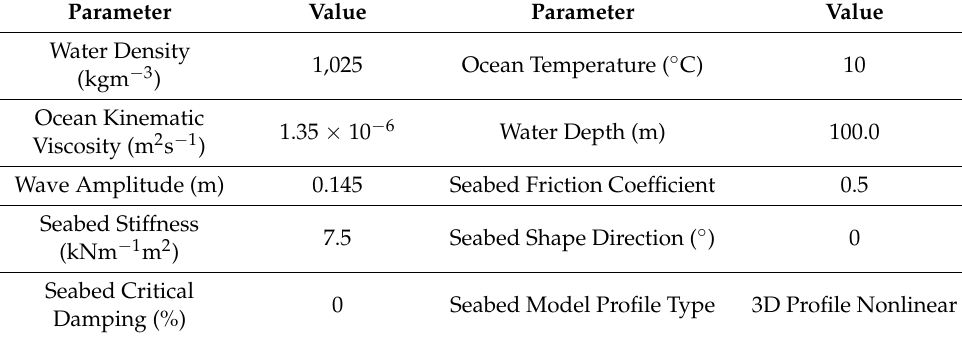
Table 6. Seabed and Ocean